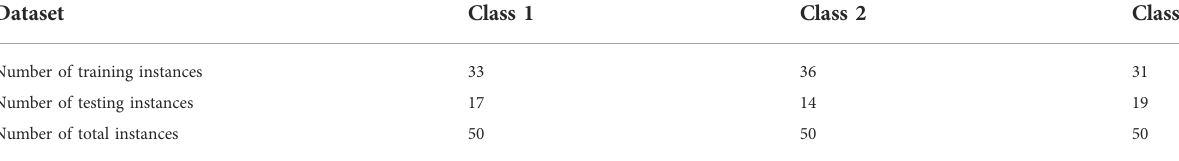
TABLE 9 Numbers of training and the testing instances of the Iris